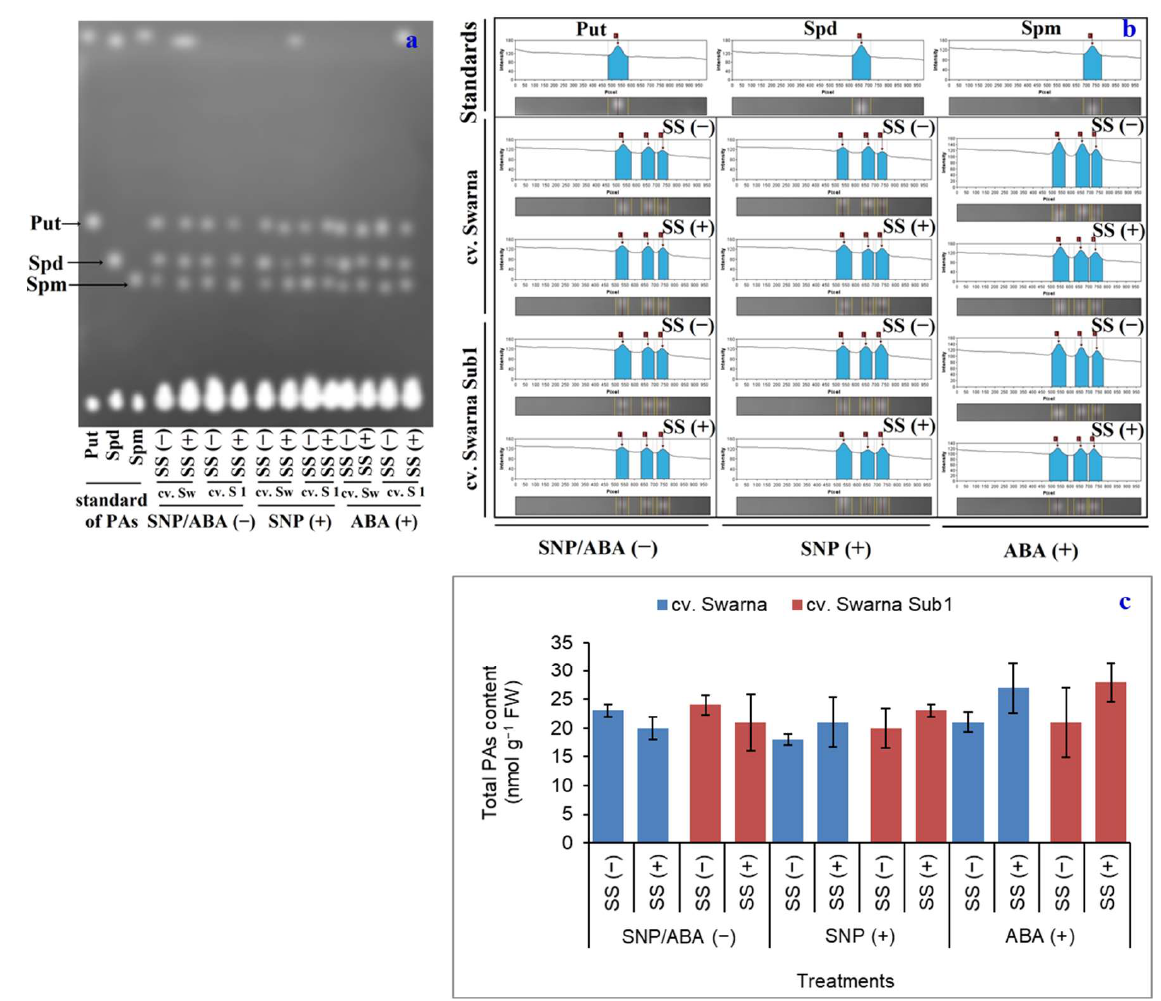
Figure 2. Separation and distribution of polyamines (Put- Putrescine, Spd- Spermidine, Spm- Spermine) from plant extract through thin-layer paper chromatography ( a ), its densitometric analysis ( b ) and quantification ( c ) in two rice genotypes (cv. Swarna and Swarna Sub1) under salinity stress [SS (+)] and non-salinity stress [SS (−)] for 72 h with [SNP (+) or ABA (+)] or without [SNP/ABA (−)] priming for 24 h. Data are presented in bars with mean ± SE ( n = 3) from independent experimental sets and the significant values are represented as * ( p ≤ 0.05), ** ( p ≤ 0.01) and *** ( p ≤ 0.001) by student’s t -test to denote the significant difference between SS (−) and SS (+) of SNP/ABA (−) as well as SNP (+) and ABA (+) of each rice genotype.